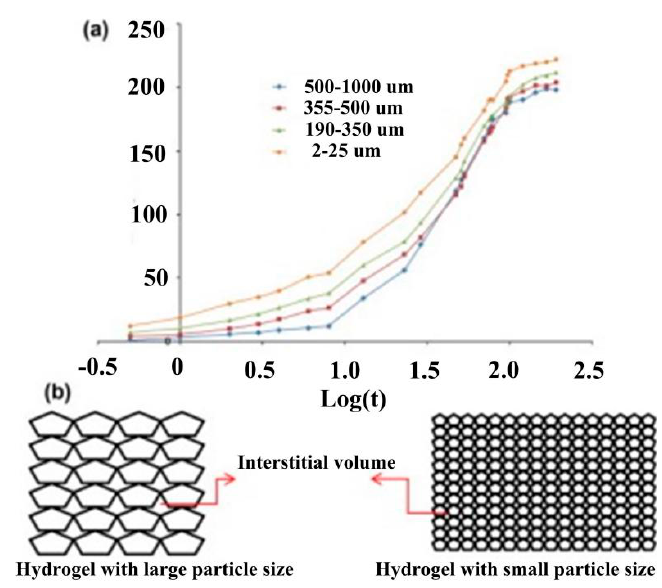
Figure 4. Semi-logarithmic plot of the effect of particle sizes on the swelling ratio of 0.1 g N-isopropylacrylamide-sodium acrylate (NIPAM-SA) hydrogels ( a ), and the schematic illustration of the interstitial volume in small and large hydrogel particles ( b ). Reprinted from Reference [50] with permission from Elsevier.